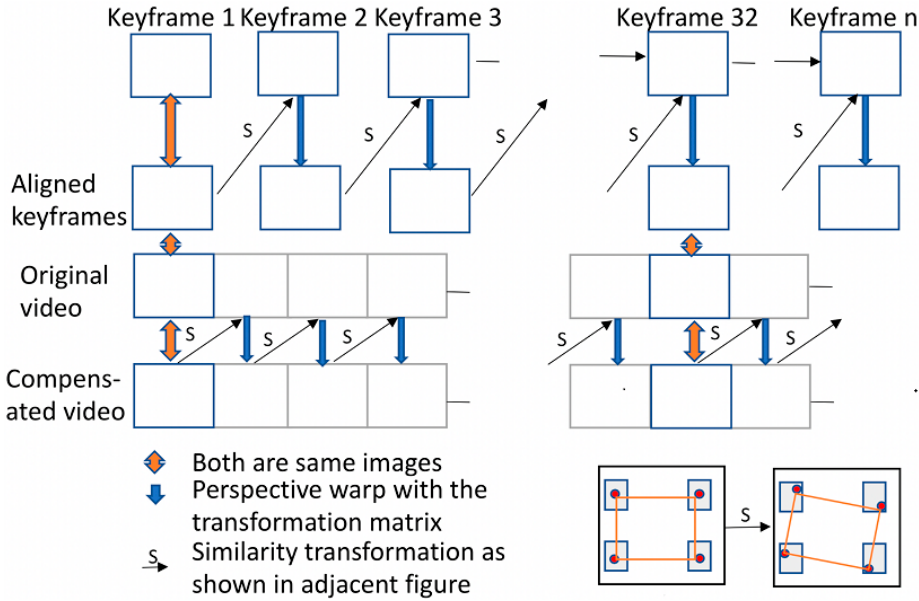
Figure 3. Temporal analysis on the basis of the comparison between successive electron micrographs.